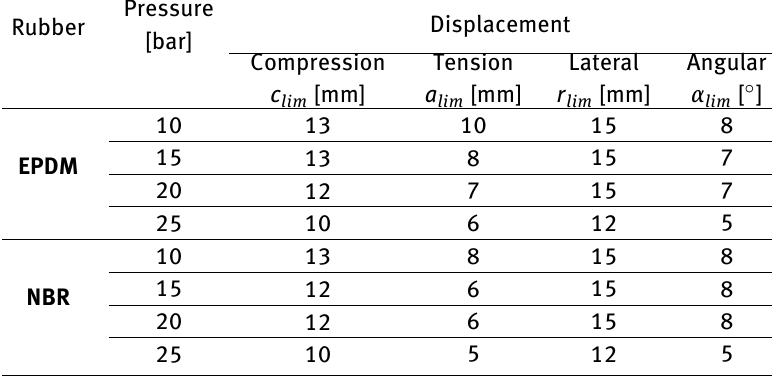
Table 3: The maximum displacement of the elastic diaphragm depending on internal pressure